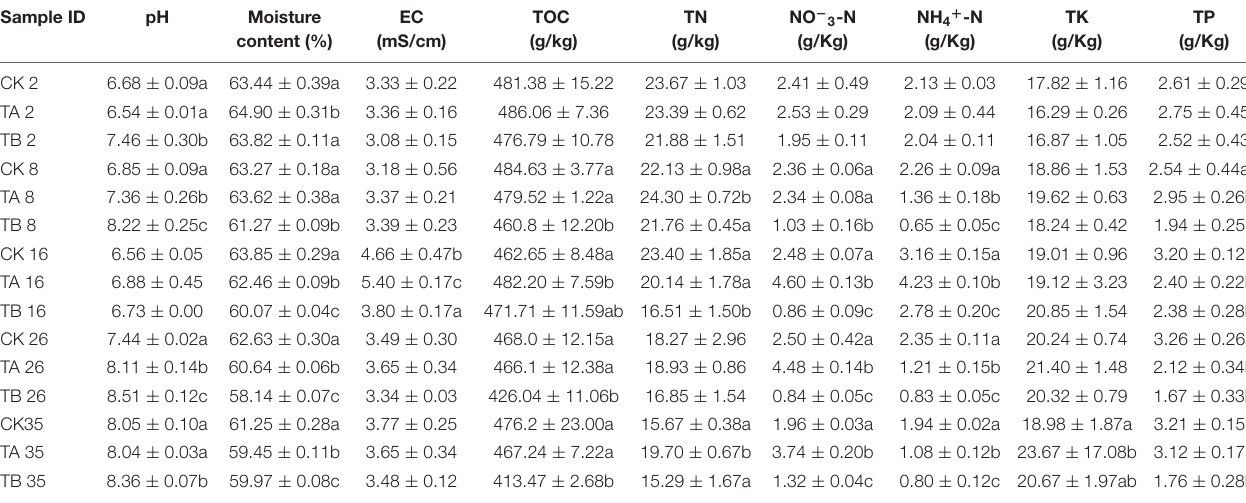
TABLE 1 | Physicochemical characteristics of the aerobic composting process for the three treatments. Sample ID